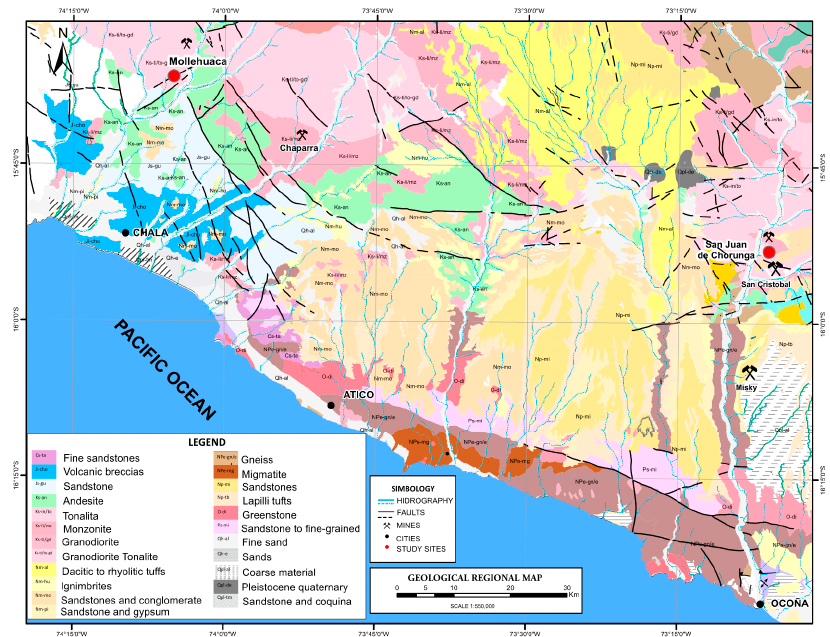
Figure 1. Geological regional map of Arequipa-Perú. Modified after INGEMMET Regional Map of Peru scale 1:100,000.